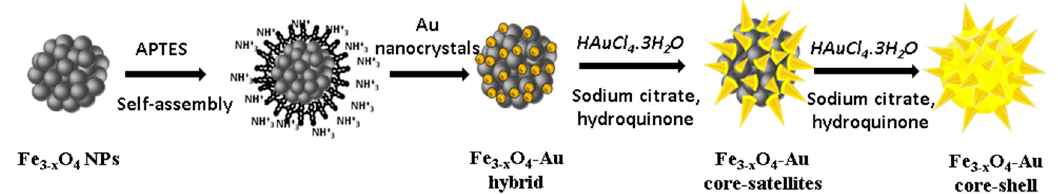
Figure 1. A schematic description of the different experimental steps involved in the production of star-shaped, Fe 3-x O 4 -Au core-shell